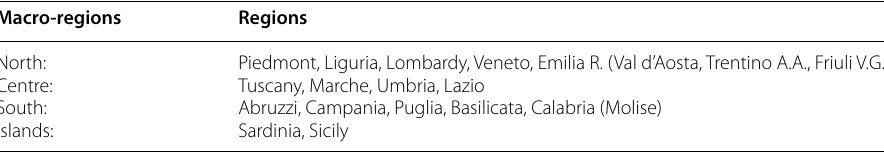
Regions in parenthesis were created later: they can be observed in recent years (e.g., 2011), but they are not reported separately in historical sources (e.g., the 1911 population census) Table 2 Observation of selected birth cohorts through the Italian censuses, at various post- reproductive ages